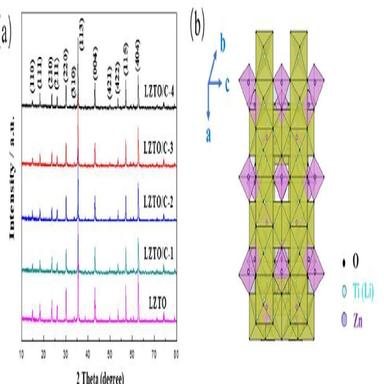
Typical XRD patterns of pristine LZTO and N-doped carbon coated LZTO samples (a). Crystal structure of LZTO (b).